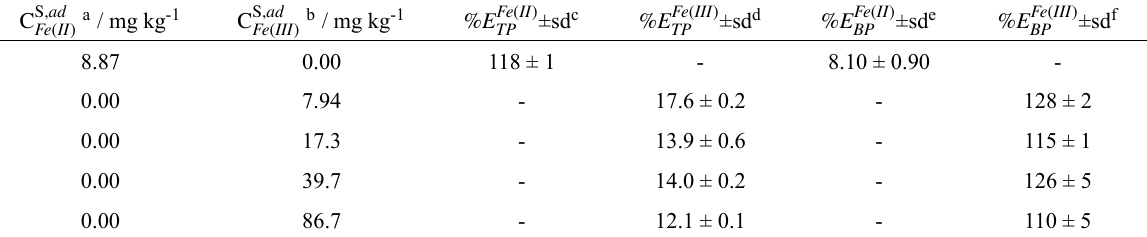
Percentage extraction of Fe(II) and Fe(III) using PEO1500+Na 3 C 6 H 5 O 7 +H 2 O ATPS at a pH of 6.00 with 5.00 mmol kg – 1 of phen.